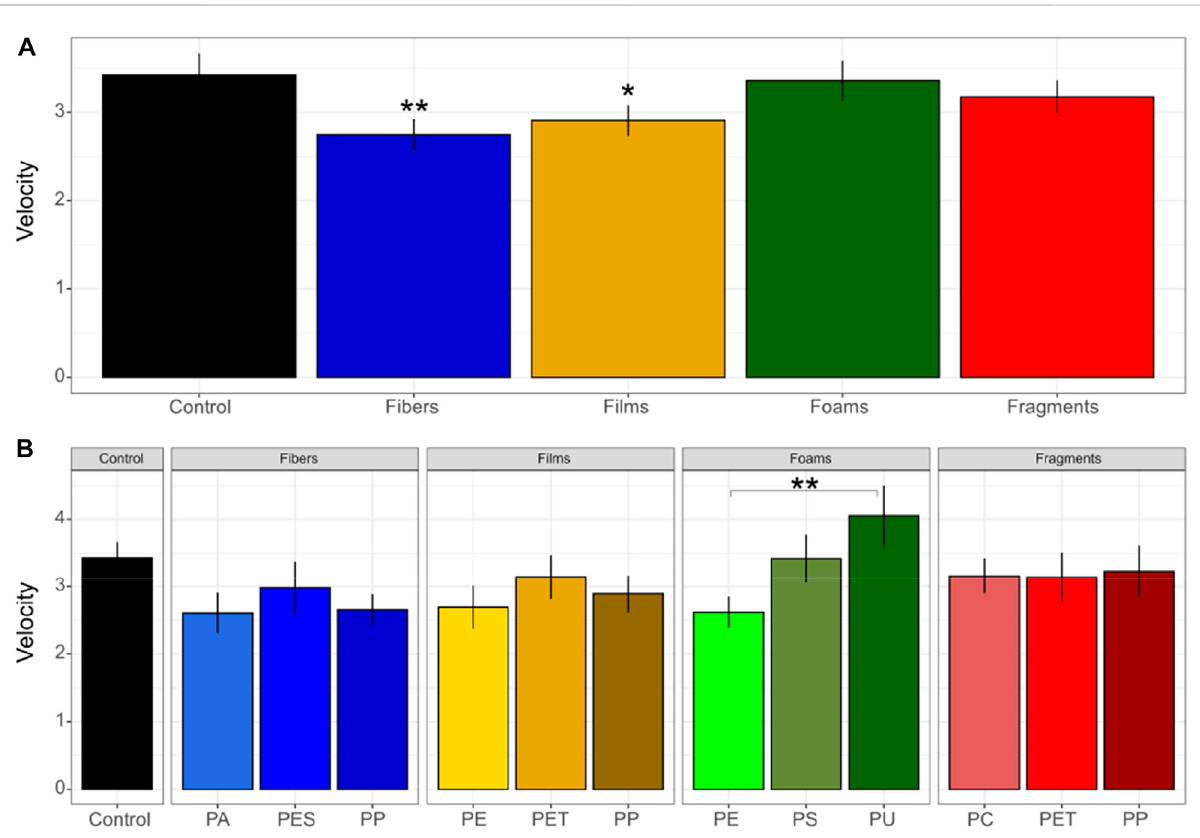
FIGURE 1 Germination velocity of seeds of Daucus carota. Microplastic shape (A) and polymer types effects (B) on germination velocity was evaluated. Differences between microplastic types and the control without microplastics) were tested using Dunnett test. Differences between polymer types within each microplastic shape were tested using Tukey test (** p < 0.05; * p < 0.1). Polymers: PA (polyamide), PES (polyester), PP (polypropylene), LDPE (low density polyethylene), PET (polyethylene terephthalate), PS (polystyrene), PU (polyurethane), and PC (polycarbonate). n = 10 for microplastics, n = 18 for control samples. The index of germination velocity denotes how rapid seeds germinate (where the minimum is 0 and the maximum is 100).